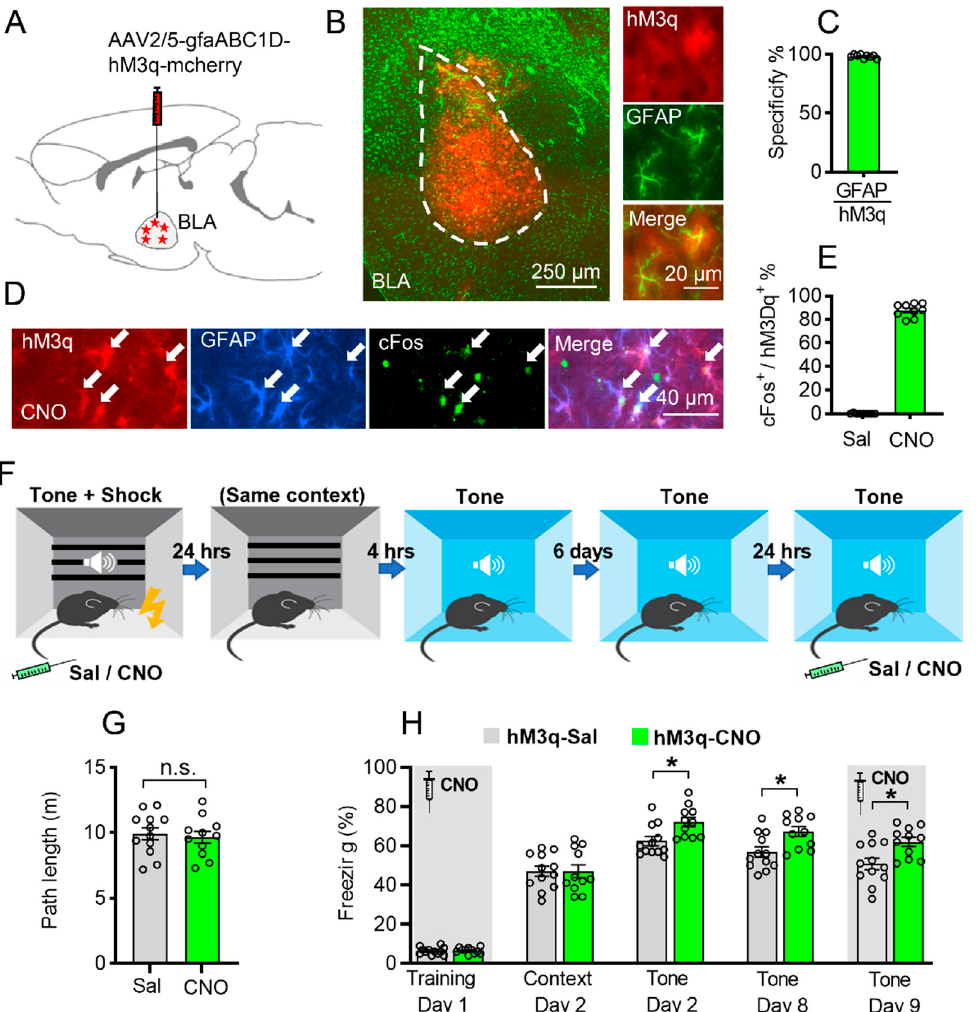
Figure 1. Astrocytic Gq activation in the BLA promotes auditorily cued fear memory formation. ( A ) Schematic picture showing AAV-gfaABC1D-hM3q-mcherry injection in the BLA bilaterally. ( B ) hM3q virus expression in the BLA (left panel); red is hM3q, green is GFAP staining, scale bar 250 µ m. Magnified view of hM3q co-expressed with GFAP (right panel); scale bar 20 µ m. ( C ) Cells with hM3q expression are highly co-labeled with GFAP (98.33 ± 0.5%, n = 3, 9 slices). ( D , E ) CNO administration to mice expressing hM3q (red) in BLA astrocytes resulted in a significant increase in c-Fos expression (green) in these astrocytes (white arrow), compared to saline-injected controls ( p < 0.0001, n = 3 per groups, 9 slices per group; blue is GFAP staining, scale bar 40 µ m). ( F ) Schematic diagram of fear memory training and contextual/auditorily cued fear memory retrieval. ( G ) Path length of exploration in the conditioning cage after CNO or saline injection ( p > 0.05, unpaired Student’s t -test, n.s. stand for no significance). ( H ) Chemogenetic activation of BLA astrocytes increased auditorily cued fear memory on day 2 ( p = 0.0367), day 8 ( p = 0.0424), but not contextual fear memory ( p > 0.05) compared to saline group. On day 9, CNO injection before auditorily cued memory test still showed significant enhancement of fear memory compared to saline group ( p = 0.0361) (Saline group n = 12, CNO group n = 11, * stands for p < 0.05, two-way ANOVA followed by Bonferroni’s post hoc test, main effect of Sal/CNO: F (1, 21) = 7.530, p = 0.0122). Data are presented as mean ±